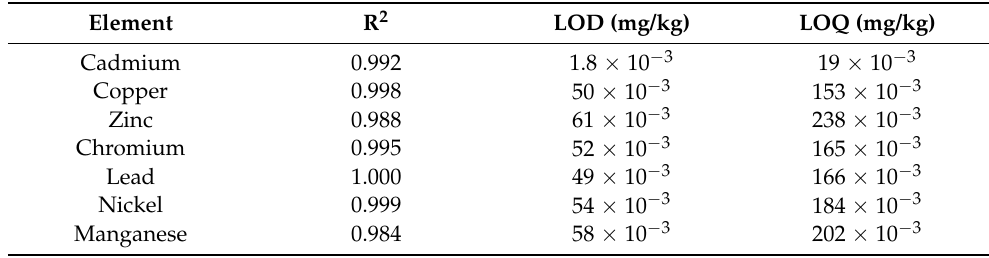
Table 1. Linear correlation coefficients (R 2 ), limits of detection (LOD) and limits of quantification (LOQ) for heavy